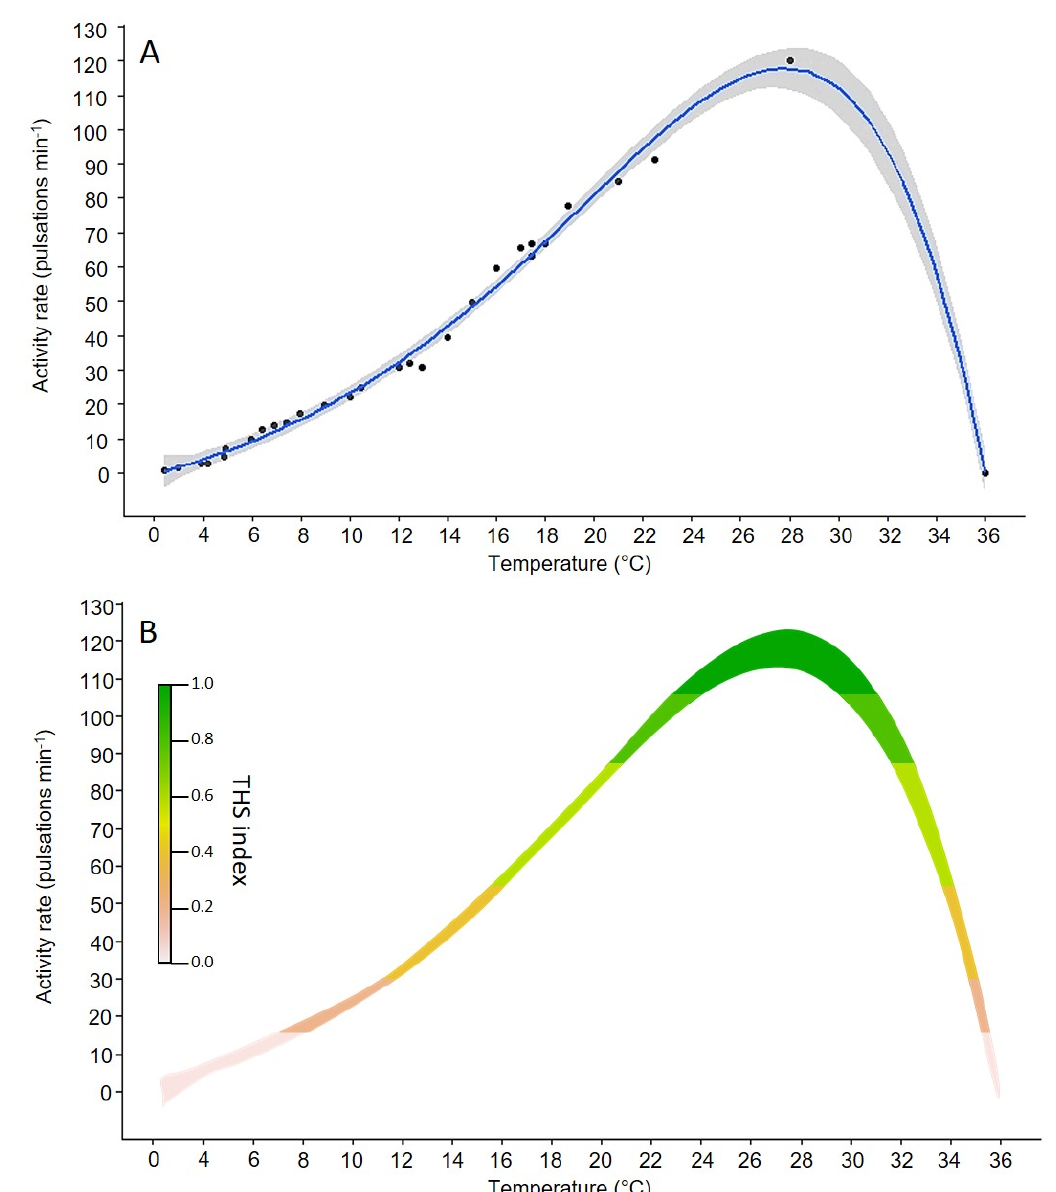
Figure 4. ( A ) Thermal tolerance curve (Boatman 2017 regression) of the medusa stage of Craspedacusta sowerbii based on the activity (pulsations min − 1 ) extracted from Thomas (1950) [30]. The blue line represents the mean regression curve and the gray area indicates the 95% confidence intervals; and ( B ) Thermal habitat suitability (THS) scale within the TPC of Craspedacusta sowerbii ranging from low (0) to high (1) species occurrence probability (THS index). Different colors in the scale bar represent the species thermal habitat suitability.